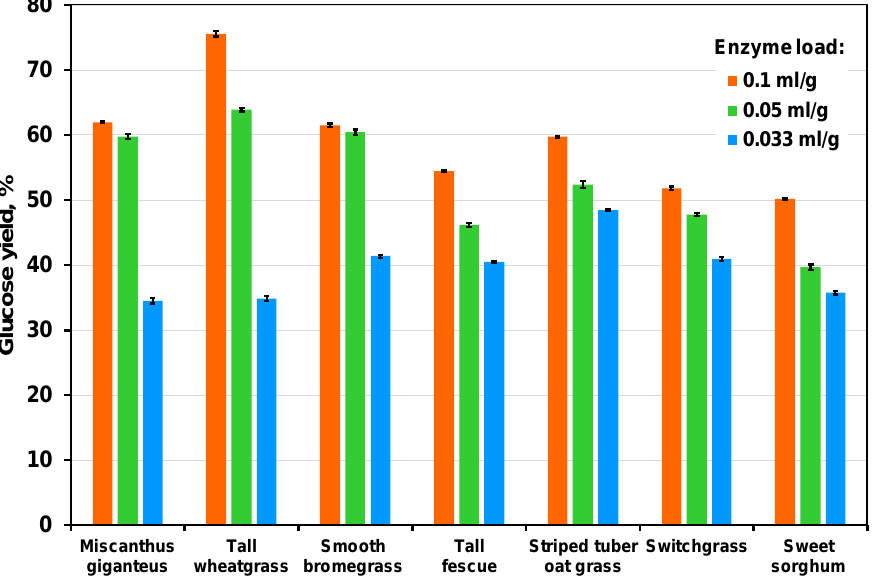
Figure 1. The e ff ect of enzyme concentration on glucose yield from 7 cellulosic pulps of di ff erent origins Figure 1. The effect of enzyme concentration on glucose yield from 7 cellulosic pulps of different (note: values are the means of triplicate assays). Energies 2019 , 12 , x FOR PEER REVIEW origins (note: values are the means of triplicate assays).